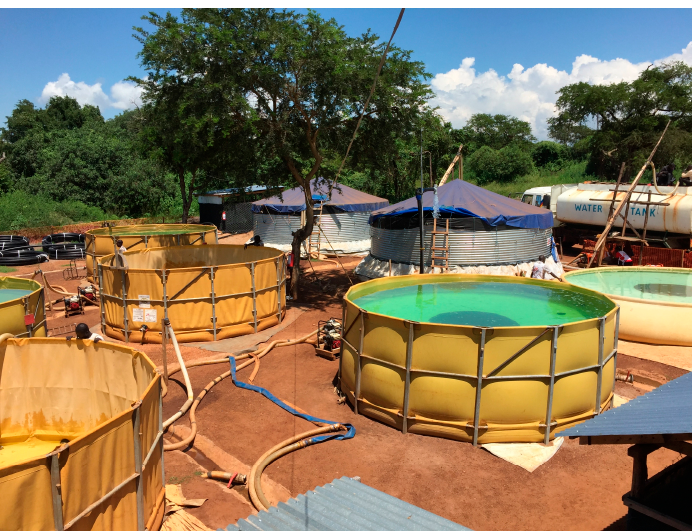
Figure 1. Image of multiple clarification tanks, clear tanks, and pumping to tanker trucks at the Palorinya surface-water treatment plant (SWTP), August 2017 (Source: Syed Imran Ali).